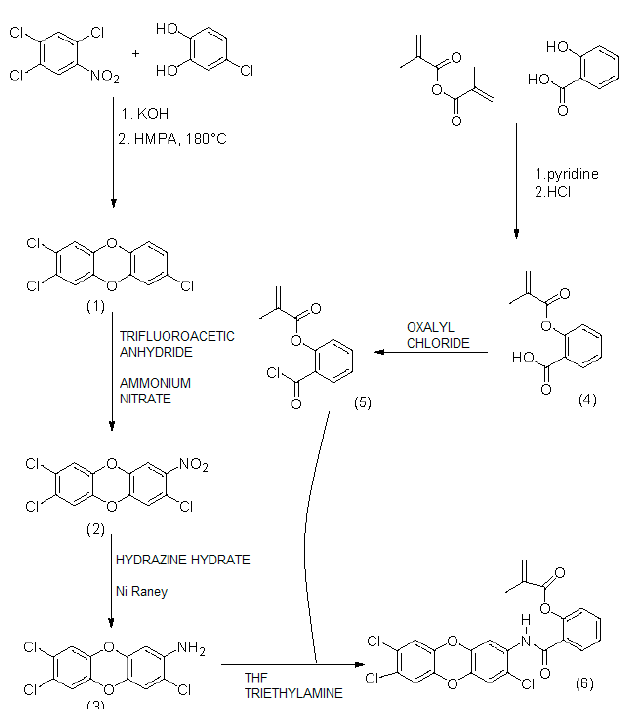
Figure 1. Synthesis of template N-(2-(3,7,8-trichlorodibenzodioxinyl))-2-metachryloiloxybenzamide) for MIP1, (adapted from Lübke et al.,